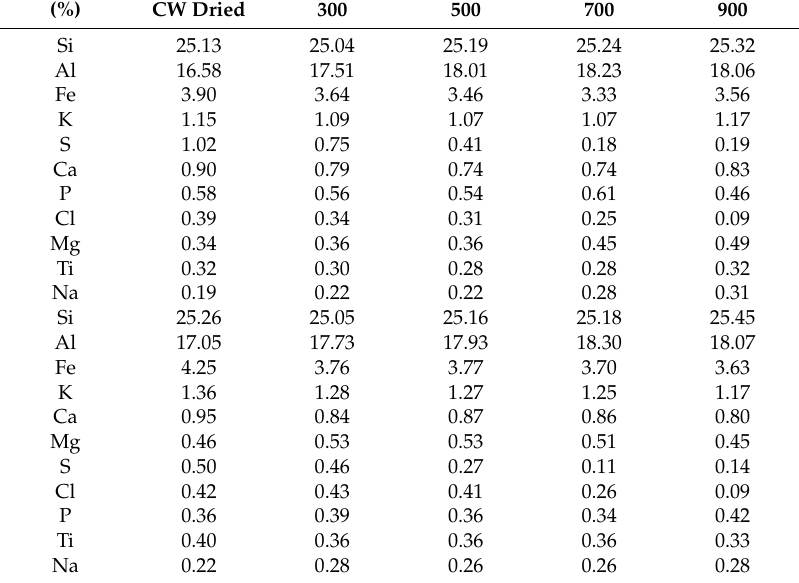
Table 4. X-ray fluorescence spectrometry (XRF) analysis results for the dried water treatment sludge and the water treatment sludge by pyrolysis temperature ( ◦